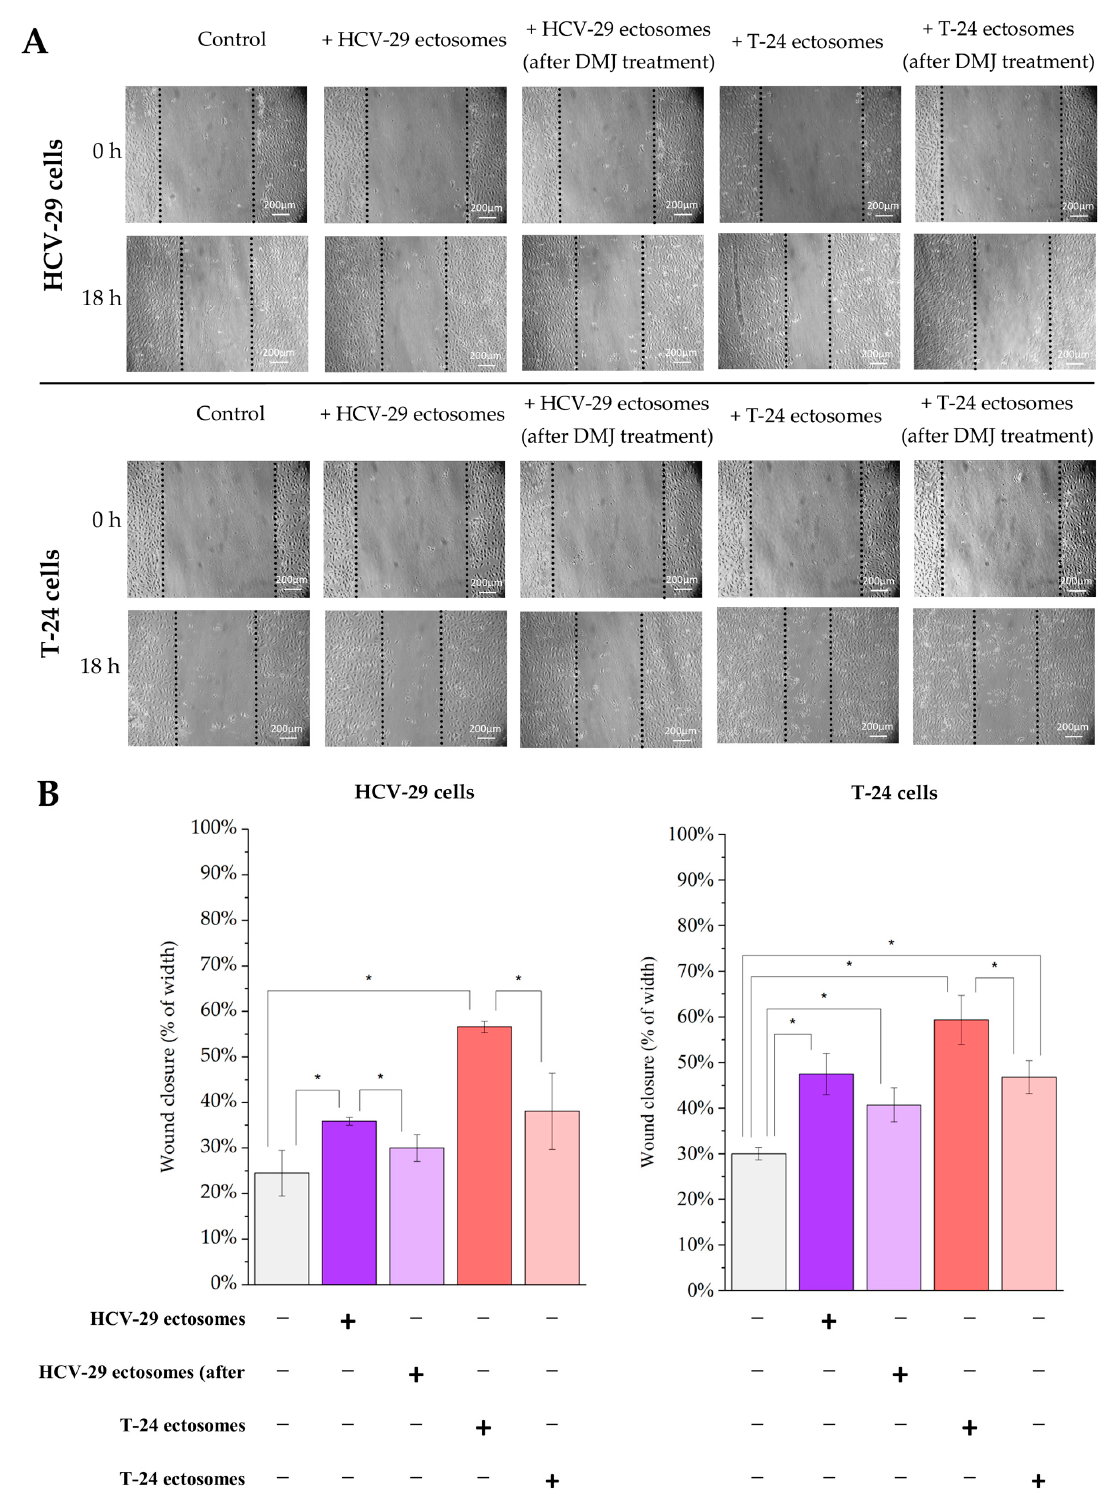
Figure 16. Effect of incubation of HCV-29 normal ureter epithelial cells ( left panel ) and T-24 urothelial bladder carcinoma ( right panel ) cells with ectosomes released by these cell lines without or after DMJ treatment on cell motility. Wound healing assay was performed after 18 h of incubation with ectosomes. ( A ). Representative images were taken at 0 h and at 18 h. ( B ). Graphs presenting the percentage rate of wound closure calculated from three repetitions. “*” denotes statistically significant differences (Tukey’s post-hoc test, p -value <